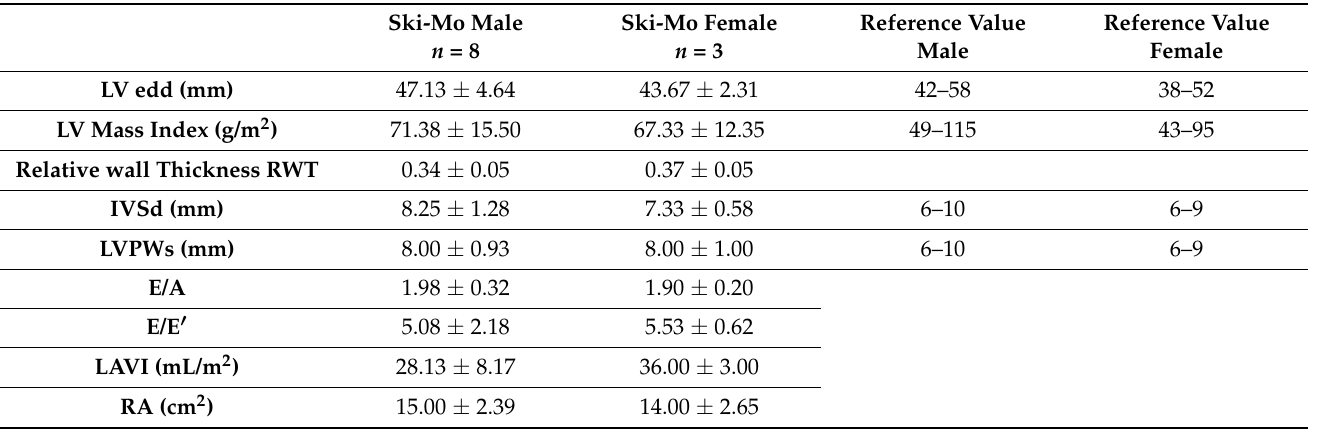
Table 2. Baseline echocardiographic measurements (mean ± SD) of the Ski-mountaineering athletes and comparison to the stated control data of the position statement paper of the DGK (German Society of Cardiology,